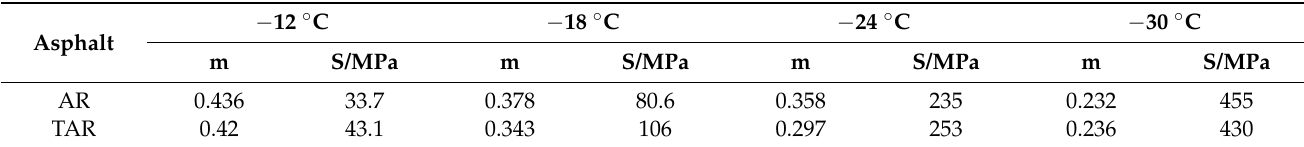
Table 12. Low temperature bending test results of AR and